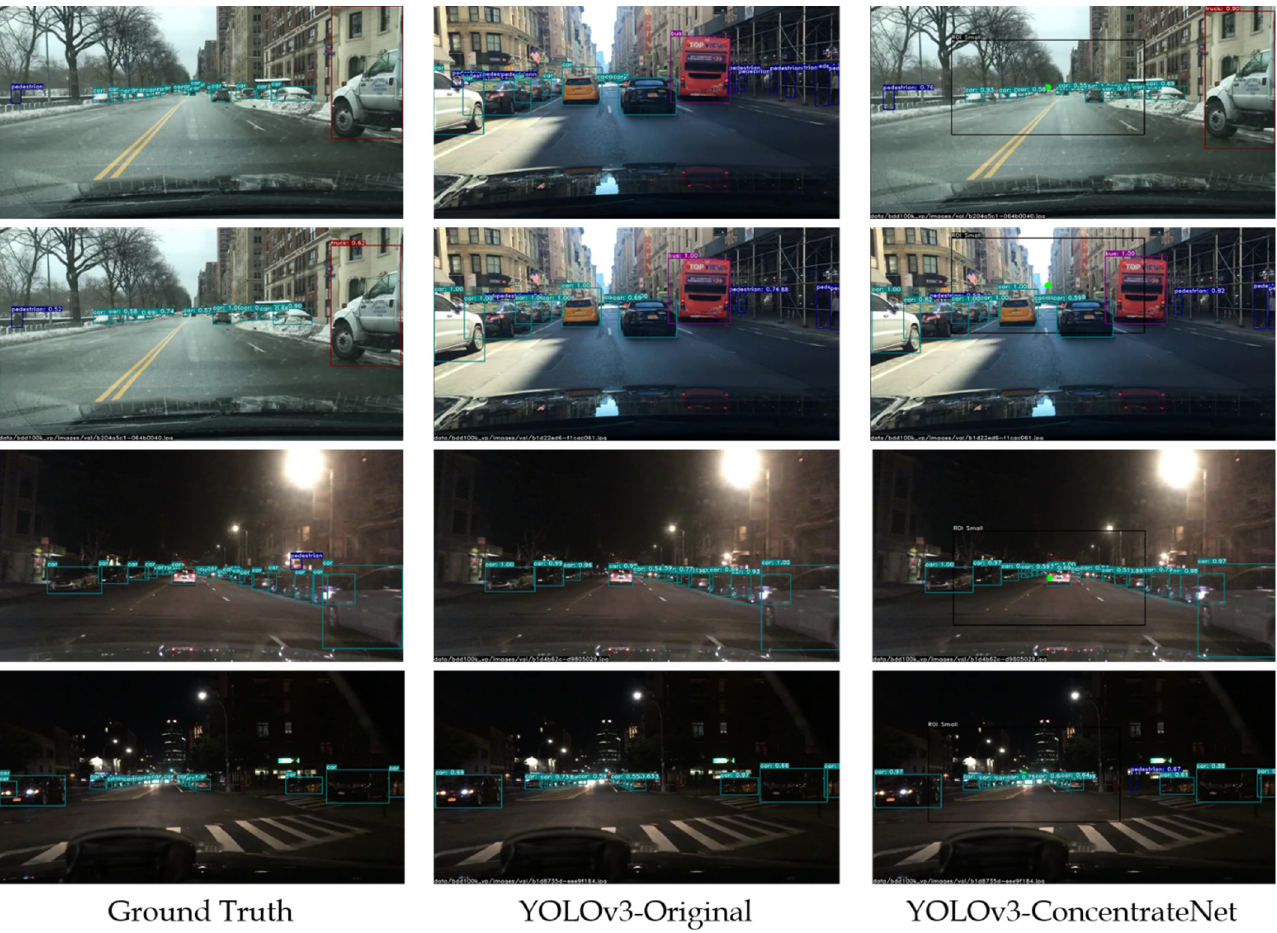
Figure 16. Visualization of model predictions.